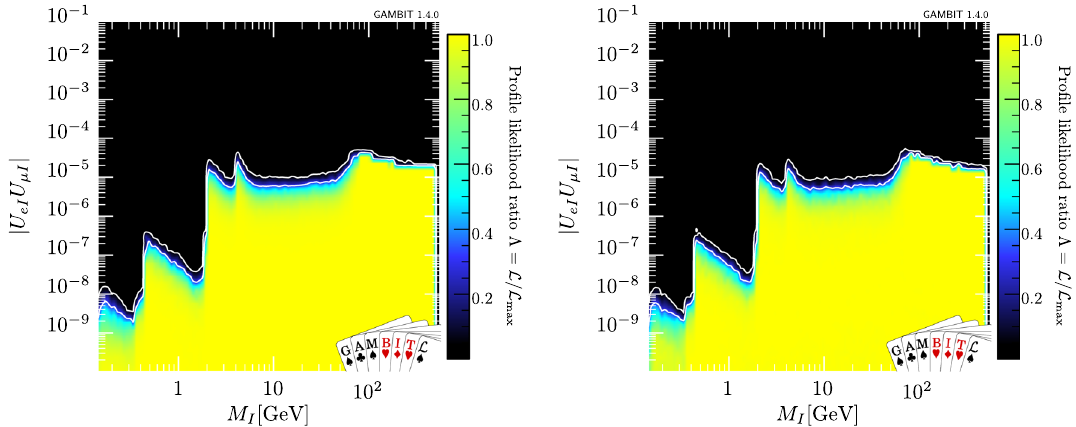
Fig. 5 Profile likelihood in M I vs | U eI U μ I | plane for normal (left) and inverted hierarchy (right). Tables with the 90% and 95% CLs for both hierarchies can be found in Zenodo [186]